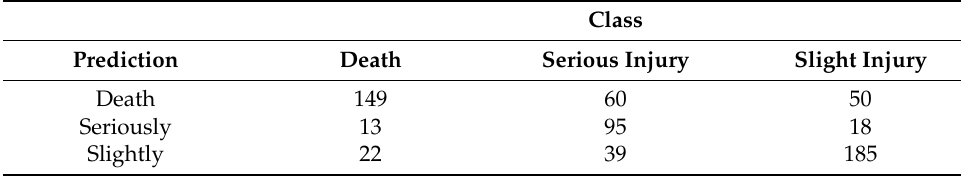
Table 3. Confusion matrix for the extended decision tree.